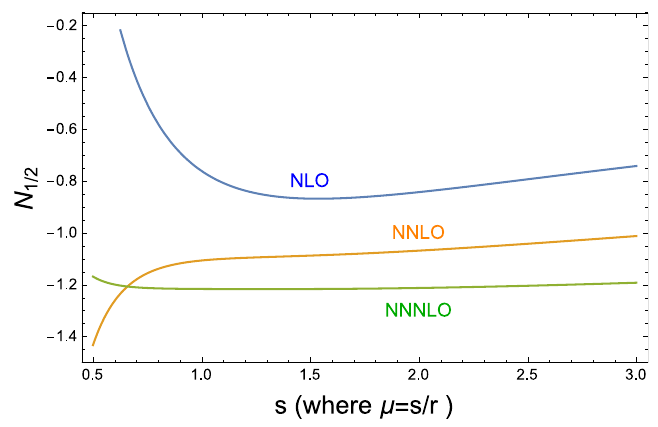
Figure 2 . Scale dependence of the normalization constant N